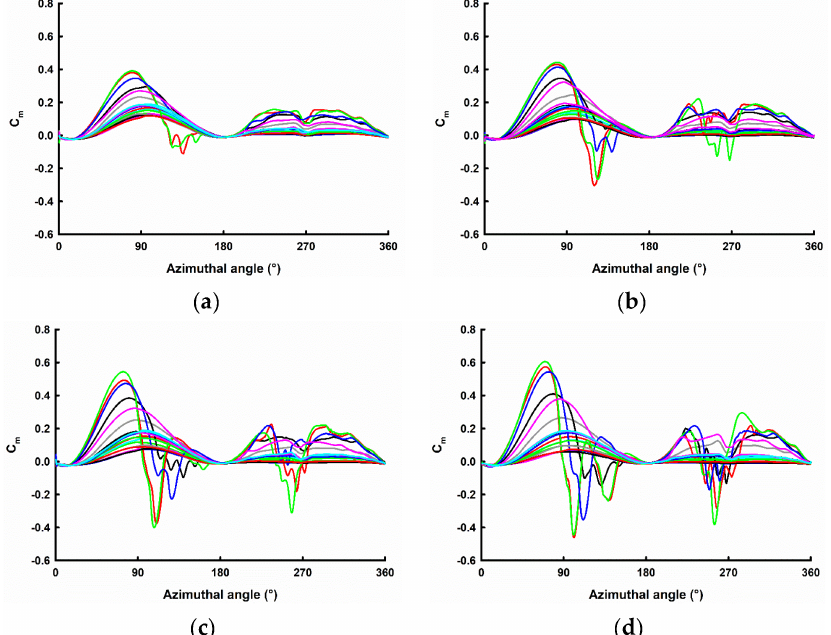
Figure 19. Variation of Coefficient of Moment C m for azimuthal Angle for ( a ) Ugust = 6 m/s; ( b ) Ugust = 8 m/s; ( c ) Ugust = 10 m/s; ( d ) Ugust = 12 m/s. Coefficient of Moment at various time instances (rotational cycles) are represented through different coloured lines. Due to randomized wind conditions, values vary every rotational